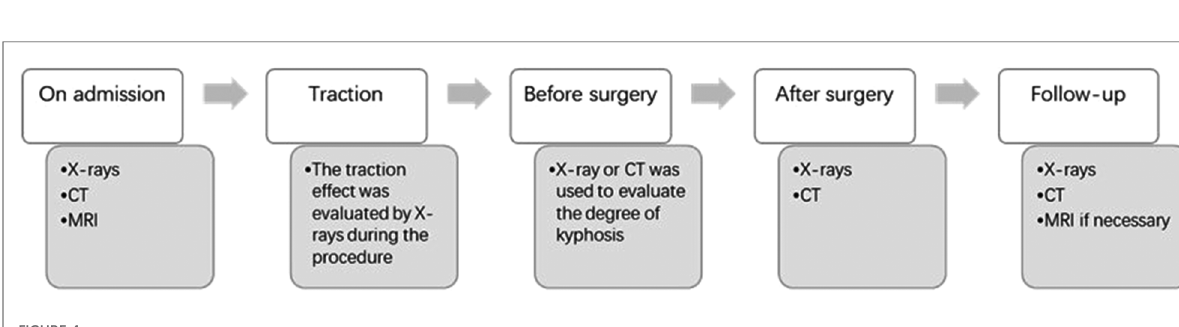
FIGURE 4 Radiographic evaluation of the patients. Radiographic evaluations were applied at fi ve time points: admission, during traction, before surgery, after surgery, and at